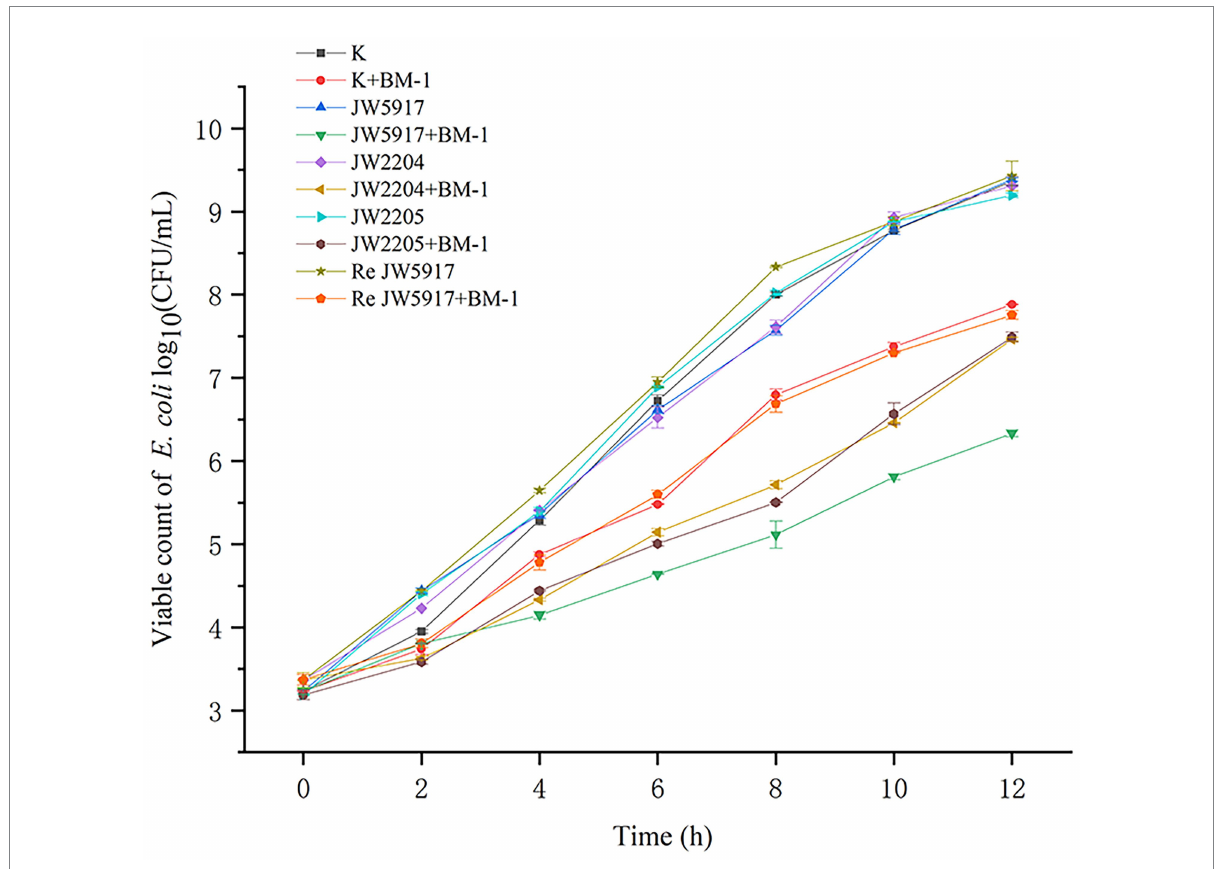
FIGURE 2 Effects of plantaricin BM-1 on the growth of wild-type E. coli K12 and mutant E. coli JW5917, JW2204, JW2205, and ReJW5917 ( p <